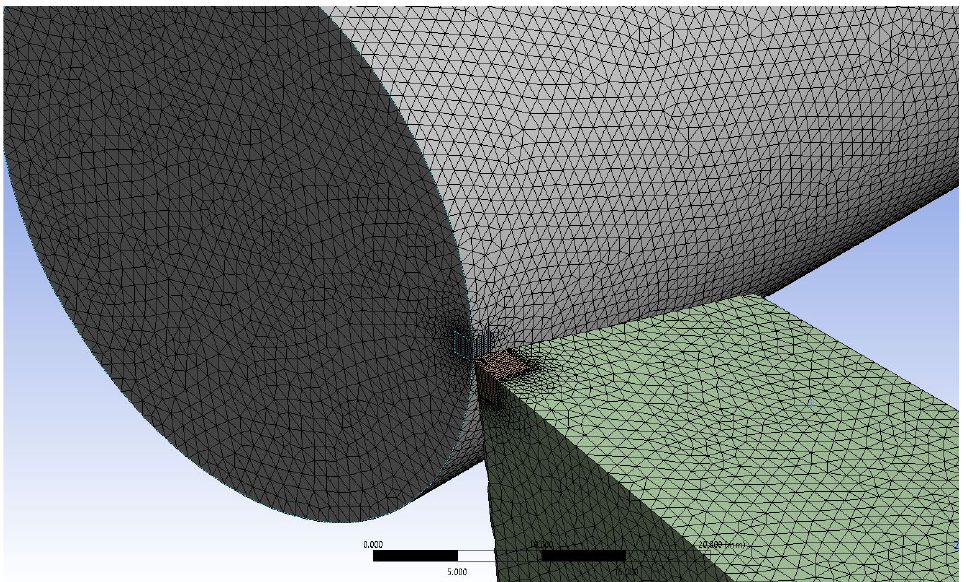
Figure 2. Meshed cutting tool and workpiece geometry with a mesh count of 2.45 million cells and an element size of 0.45 mm.